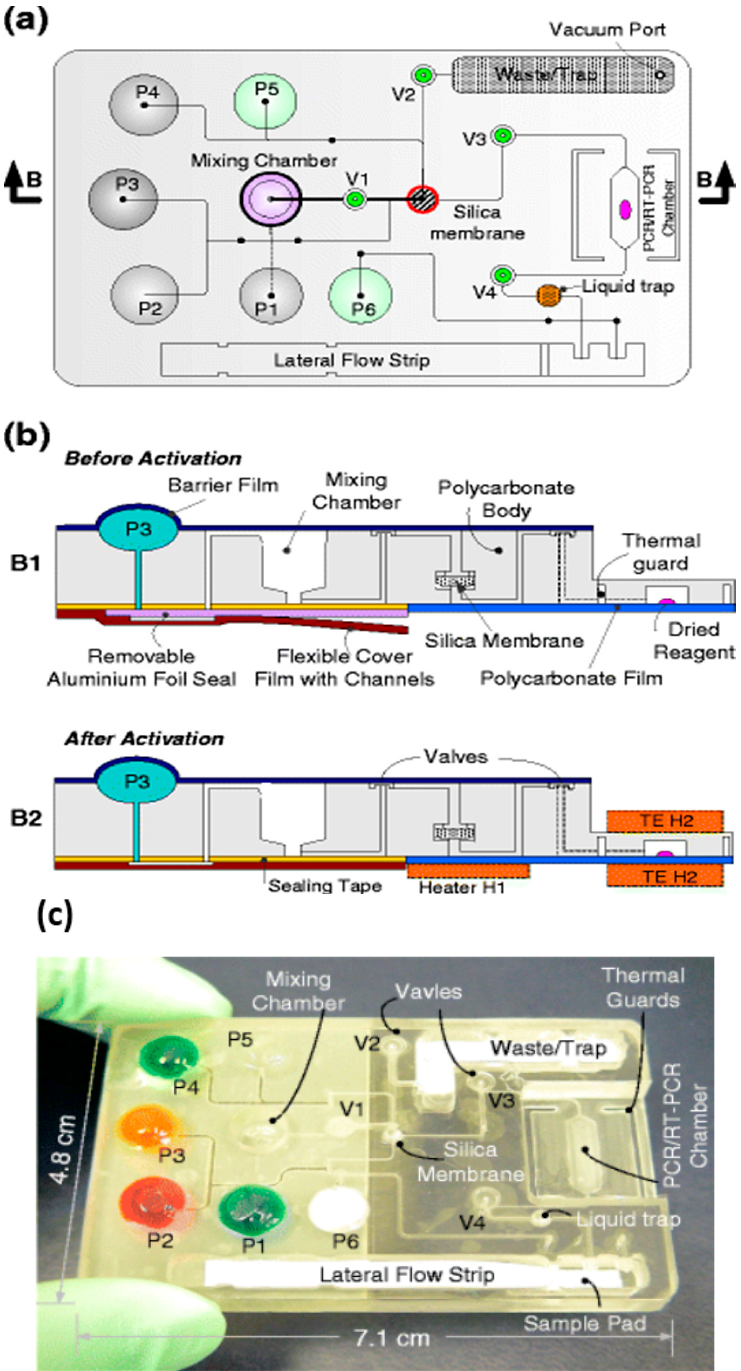
Figure 5. Pouch-based chip integrating sample lysis, solid-phase nucleic acid extraction with a porous silica membrane nucleic acid binding phase, RT-PCR/PCR (reverse transcription polymerase chain